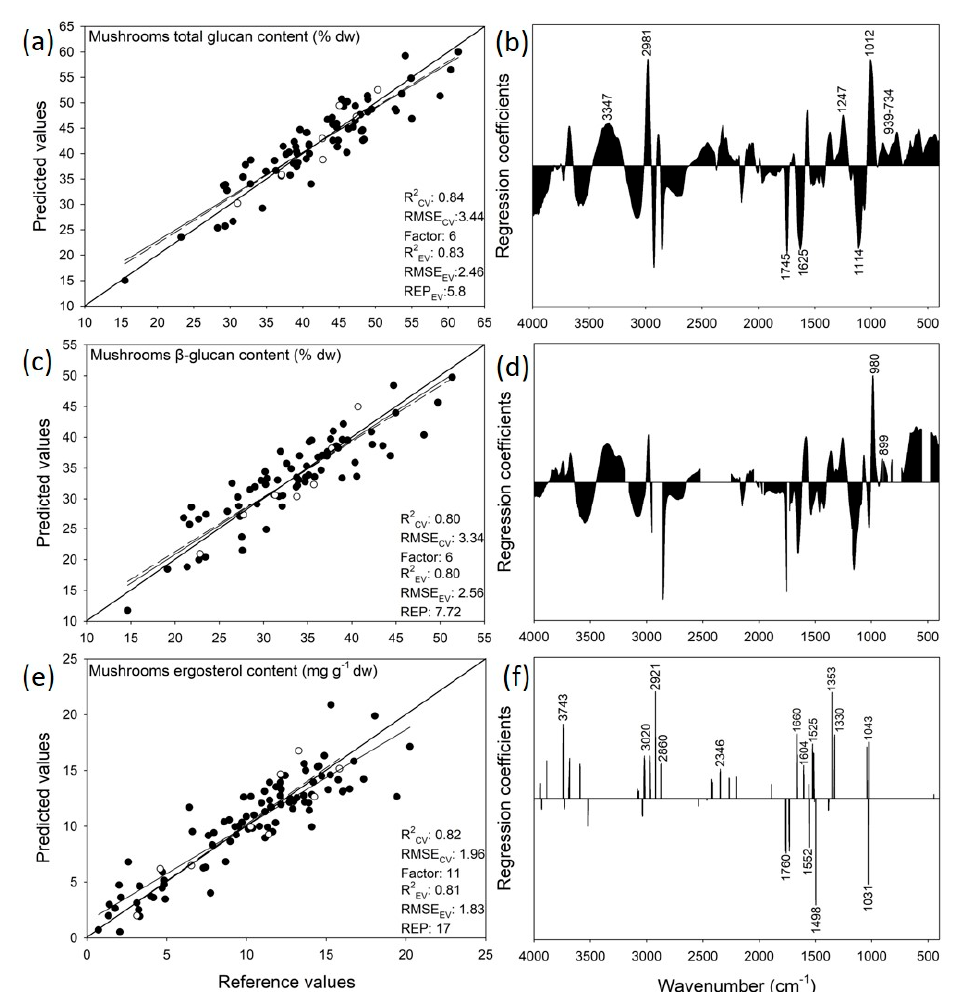
Figure 6. The measured vs. the predicted values and regression coe ffi cients of calibration for the prediction model of ( a , b ) the total glucans content, ( c , d ) the β -glucans content and ( e , f ) the ergosterol content in the Pleurotus